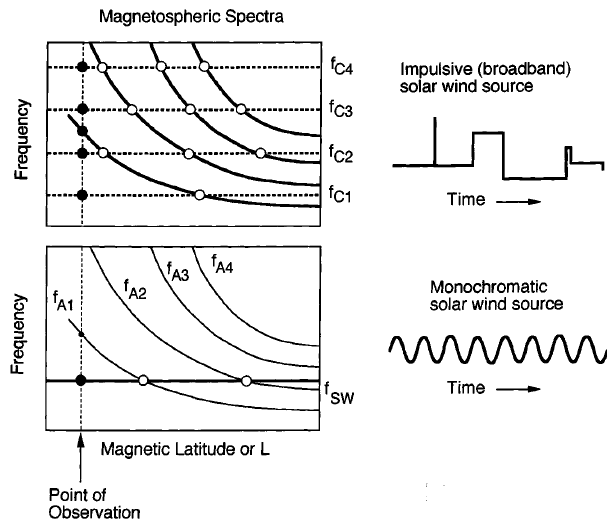
Fig. 2. Illustrations of two types of ULF sources in the solar wind and the magnetospheric response. In the case illustrated at the top , the source consists of irregular and impulsive variations. This is e(cid:128)ectively a broadband source, which can excite a number of cavity mode oscillations and multiharmonic standing Alfve´ n waves (Alfve´ n continuum) in the magnetosphere. In the case illustrated at the bottom , the solar wind source is a sinusoid. This source causes the magnetosphere to oscillate at the same frequency with little trace of the Alfve´ n continuum except on L shells on which the Alfve´ n frequency matches the source frequency. The size of the solid circles indicates the wave intensity at an observation